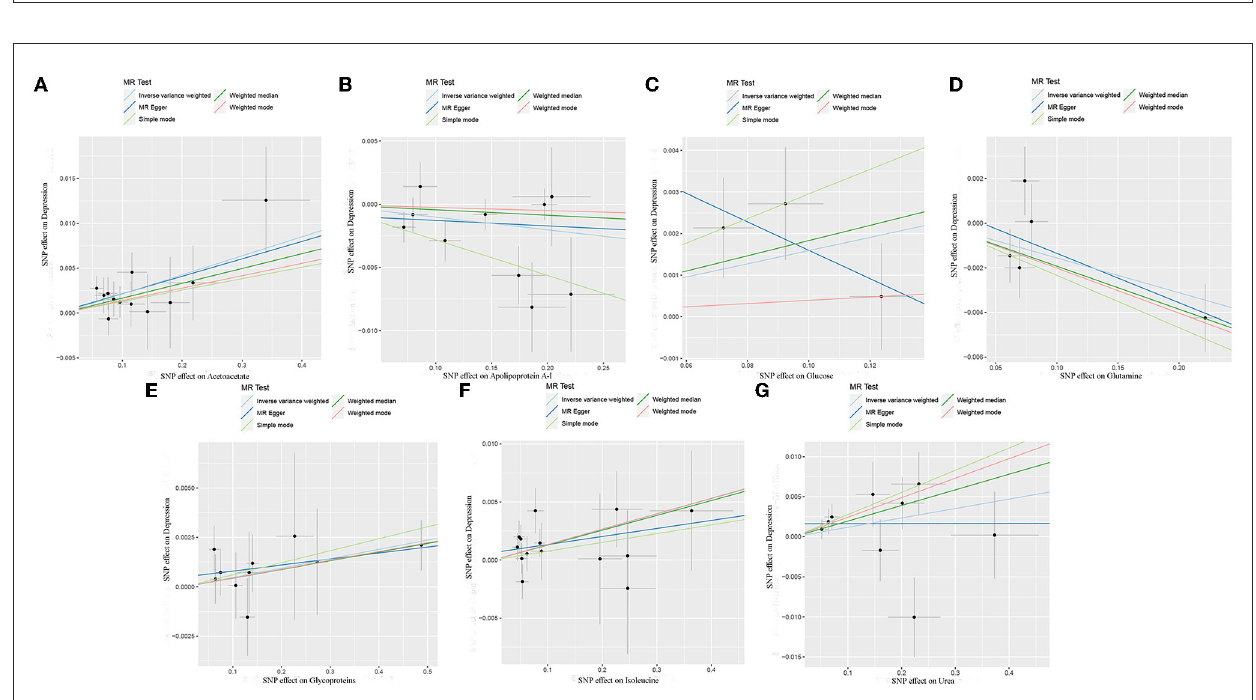
FIGURE4 Scatter plots of each metabolite associated with depression. (A) , Acetoacetate; (B) , Apolipoprotein A-I; (C) , Glucose; (D) , Glutamine; (E) , Glycoproteins; (F) , Isoleucine; (G) , Urea.